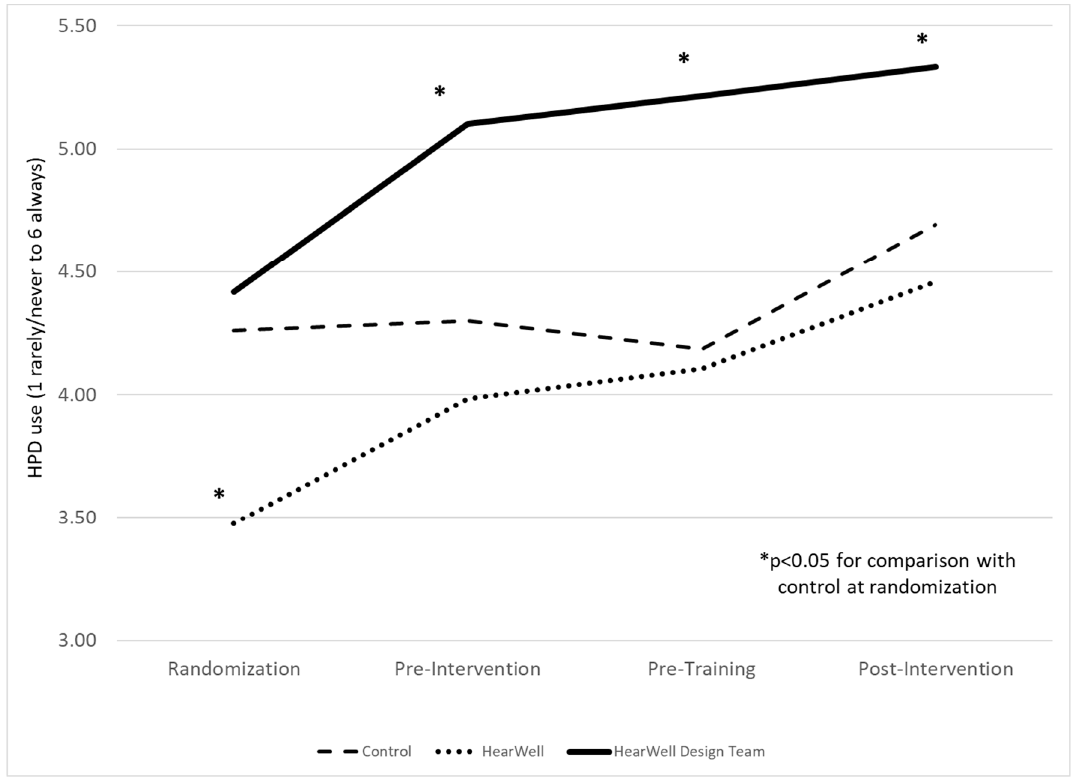
Figure 2. Reported frequency of HPD use across surveys by intervention arm among transportation maintainers. Mixed linear models accounting for repeated measures were used to evaluate difference between survey periods and intervention arms. Statistical significance ( p < 0.05) is presented for the comparison between each time period, by intervention arm with respect to the control values at randomization. Table 5. Hearing climate by intervention arm pre ‐ training and post ‐ intervention. p ‐ values represent the statistical significance as compared to the control at pre ‐ training using a mixed linear model.